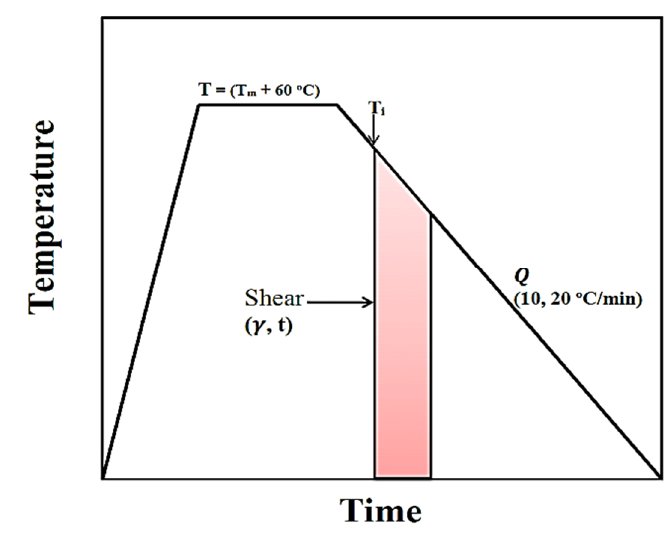
Figure 1. Schematic indication of thermal and shear treatment for crystallization process.